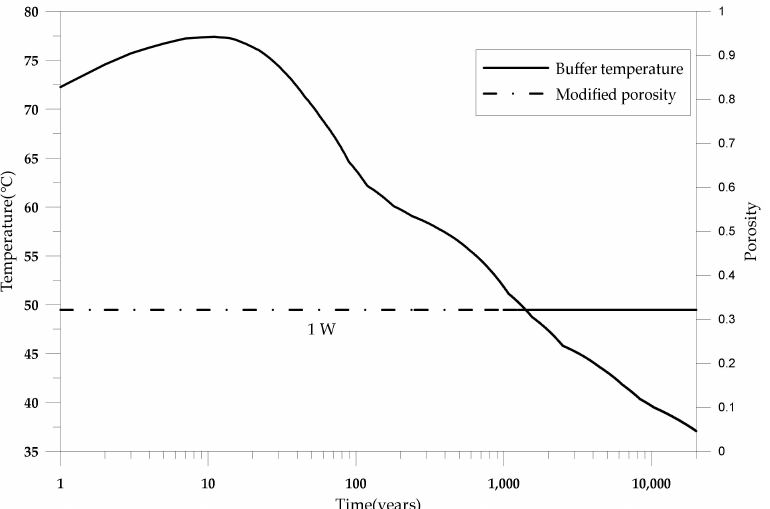
Figure 13. Average temperature evolution and the modified porosity as a function of time within the buffer